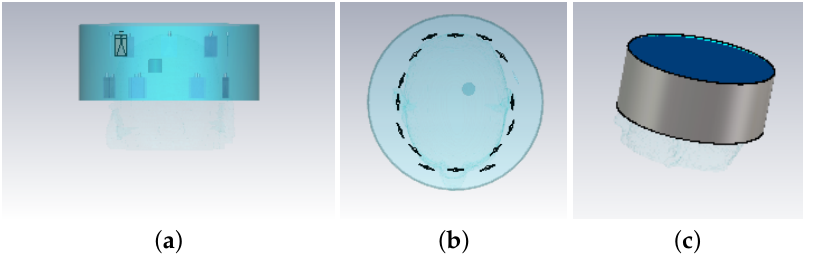
Figure 14. ( a ) Top and ( b , c ) side views of the setup used in Section 3.2. A headband is placed at the top of the head phantom, and sixteen antennas are placed in a two ring array inside the headband, with 8 antennas for each